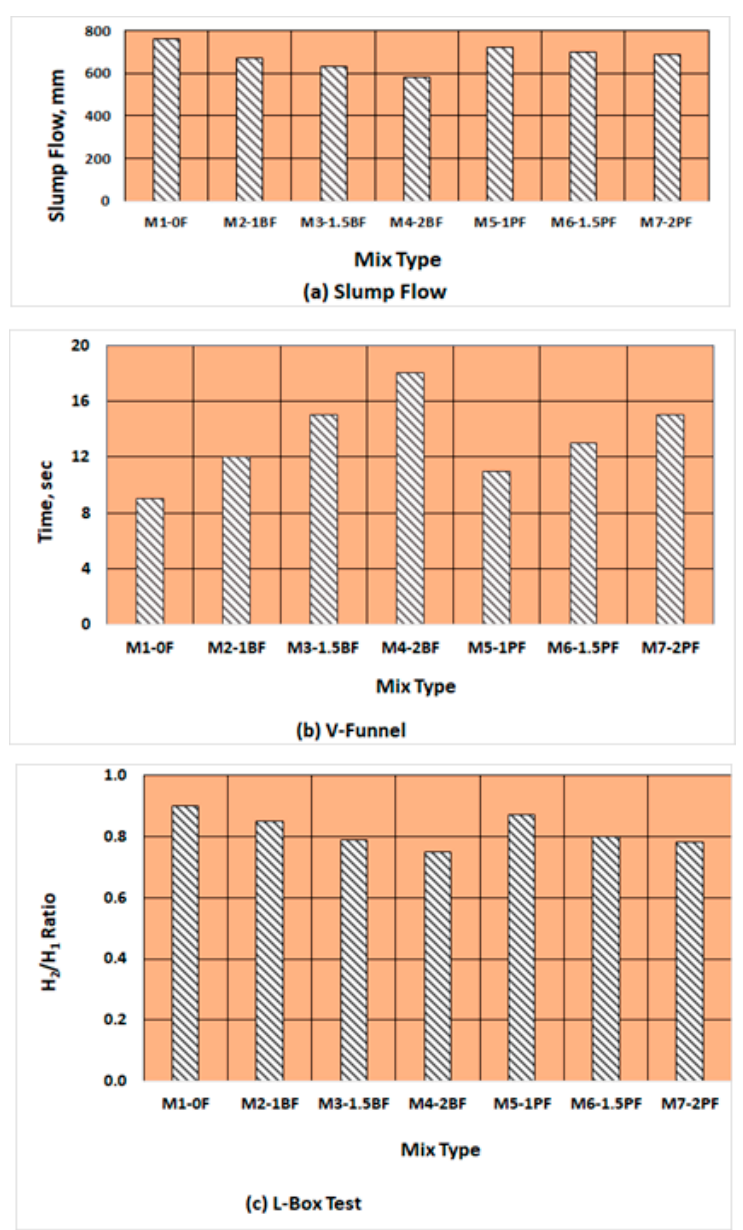
Figure 4. Fresh concrete test results ( a ) slump-flow ( b ) V-funnel ( c ) L-box.